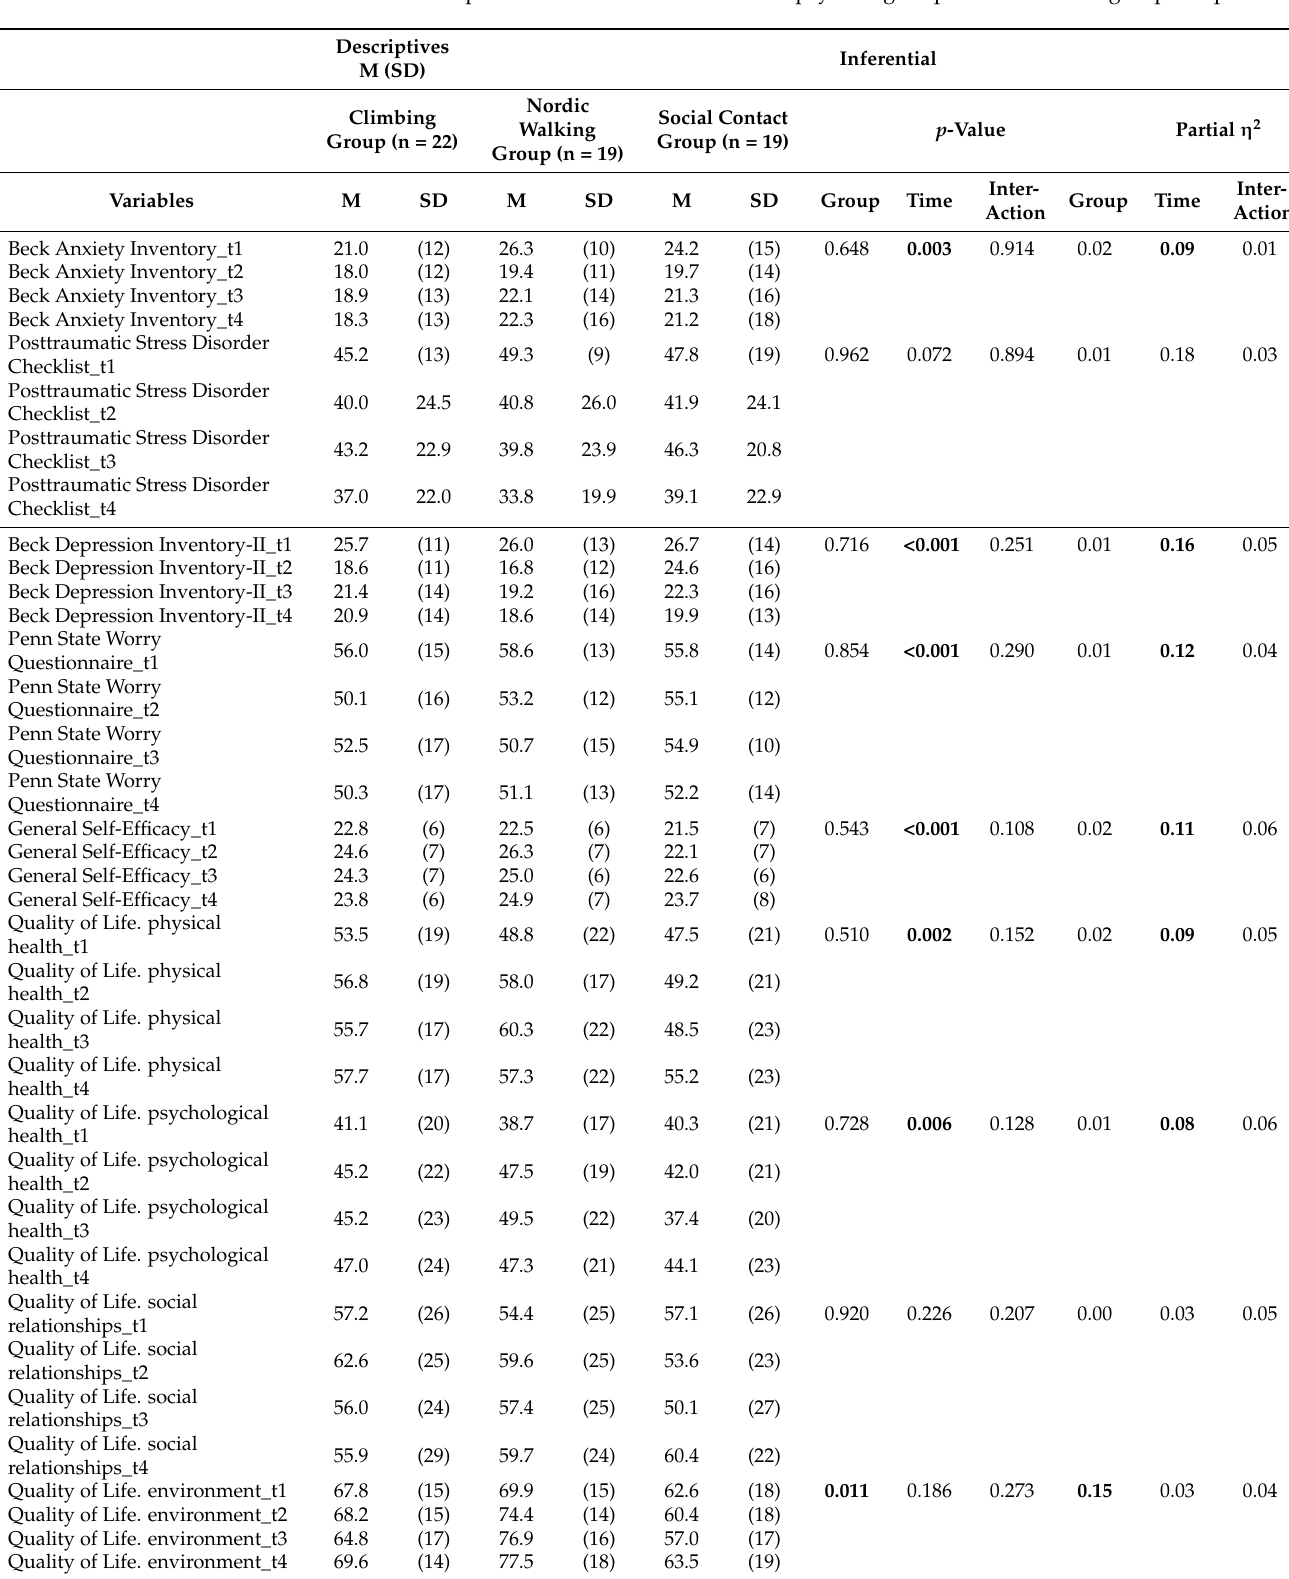
Table 2. Descriptive and inferential values of the psychological parameters of the group